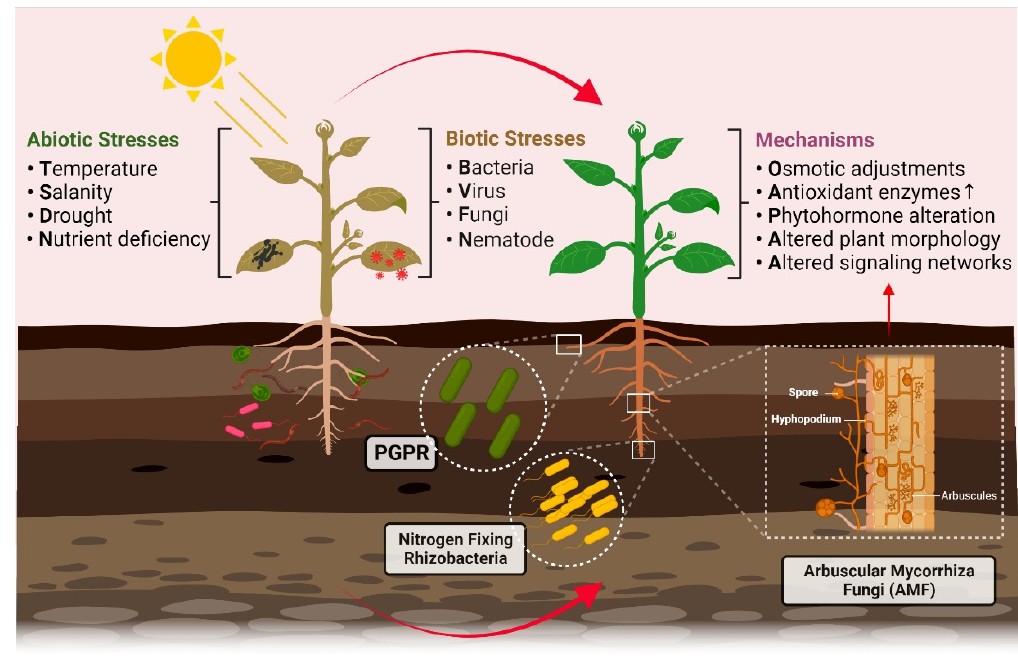
Figure 2. An overview diagram showing major environmental stresses and mechanisms of plant– microbe interactions that influence plant fitness during these stresses. Tolerance against these stresses is mainly mediated by enhancement in antioxidant defense enzymes, osmotic adjustment and production of phytohormones. PGPR: plant growth-promoting rhizobacteria.